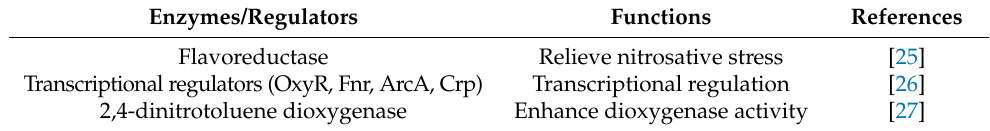
Table 1. Interactions between VHb and intracellular enzymes or